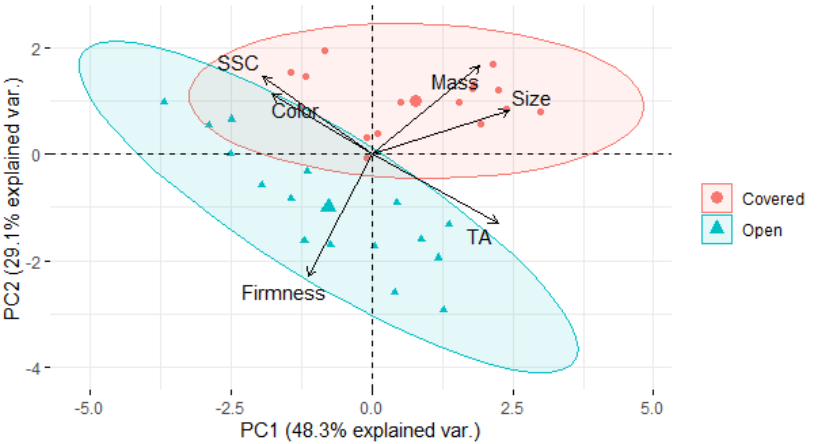
Figure 2. Principal component analysis (PCA) biplot of the physicochemical properties of fruit obtained from Plots 1 and 2 of ‘Santina’ sweet cherry cultivars on ‘Colt’ rootstock, at harvest. The PCA biplot exhibits the PCA scores of the quality characteristics as vectors for fruit from both plots and vs. environmental conditions to the first and second principal components.